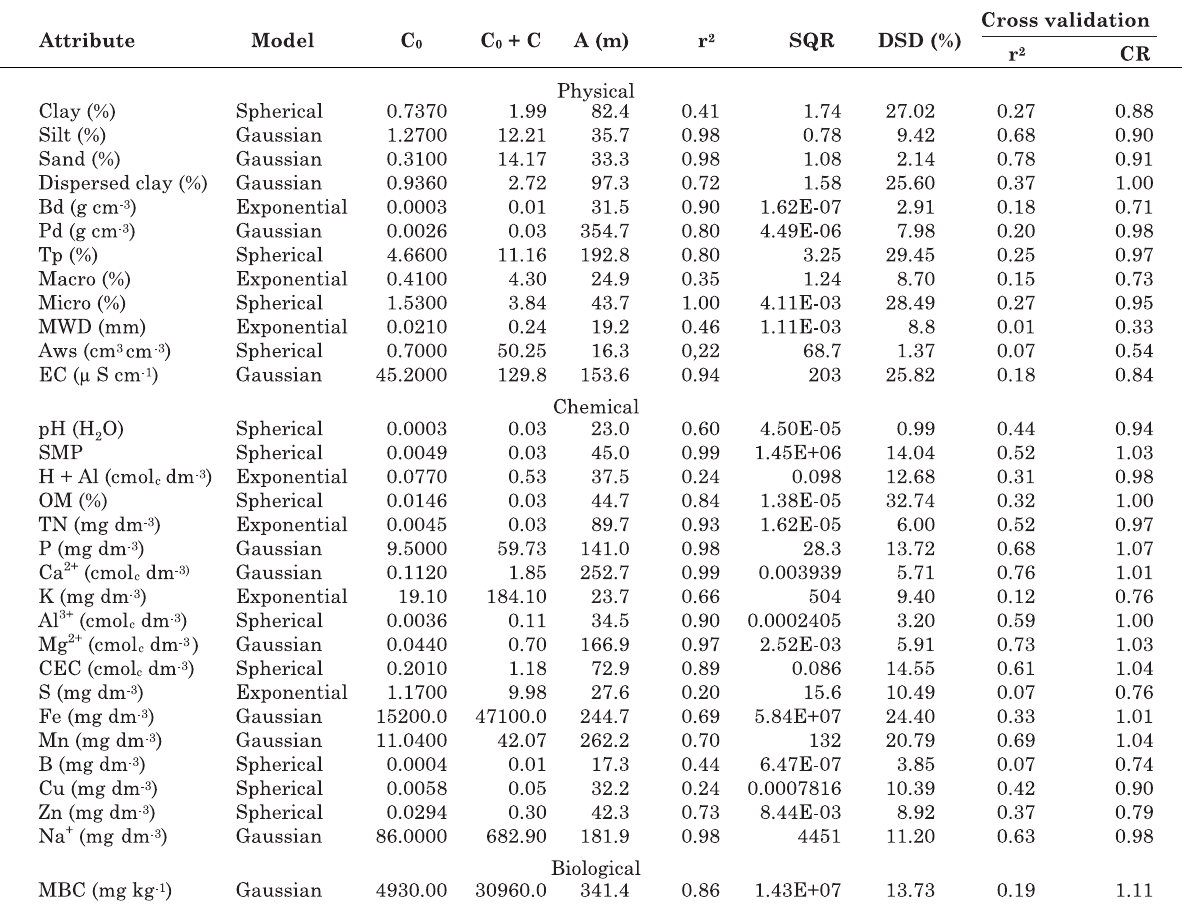
Table 3. Adjusted mathematical models to the experimental semivariograms and their respective parameters (nugget effect, sill and range), coefficient of determination and sum of squares of residuals, degree of spatial dependence and the results of cross validation (coefficient of determination and the coefficient of regression) of all studied soil